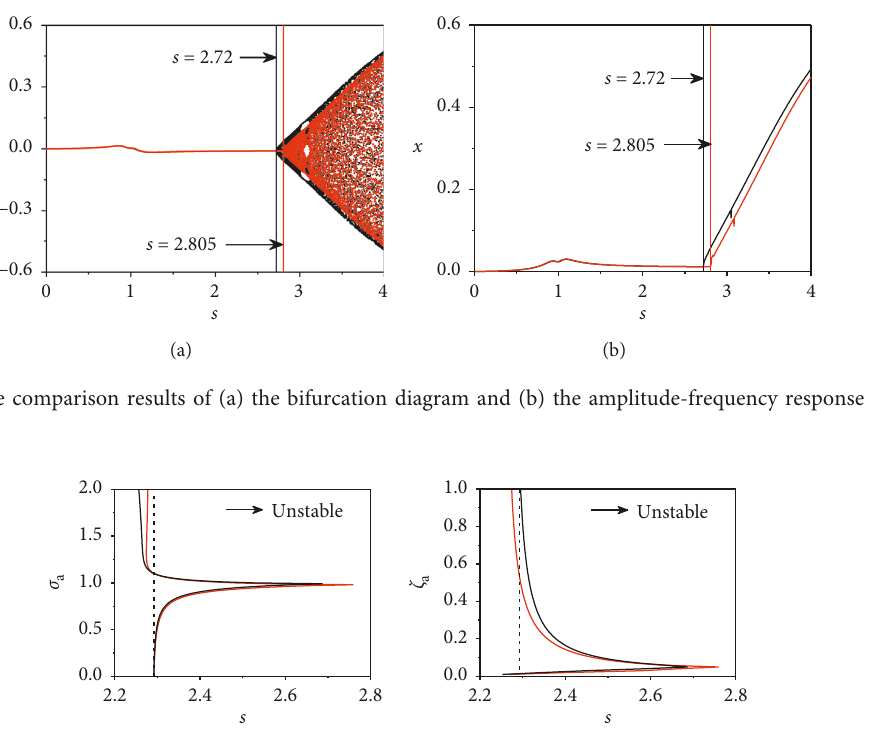
a and (b) the damping